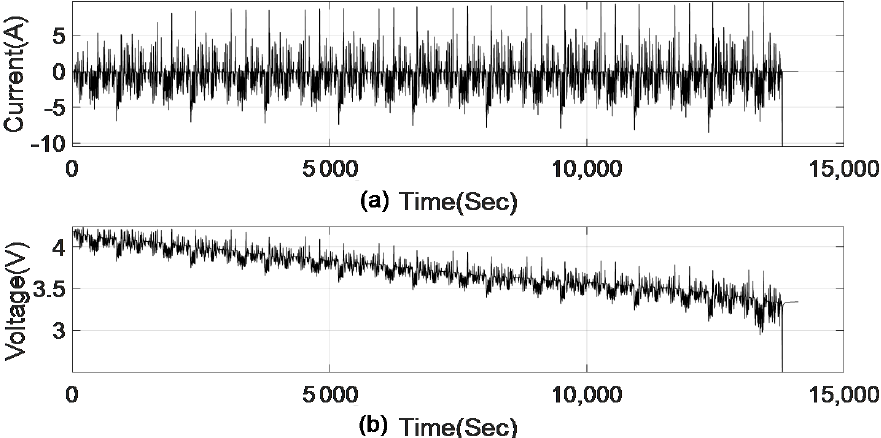
Figure 4. Experimental data for model validation (LA-92 Driving cycle): ( a ) Current; ( b ) Voltage